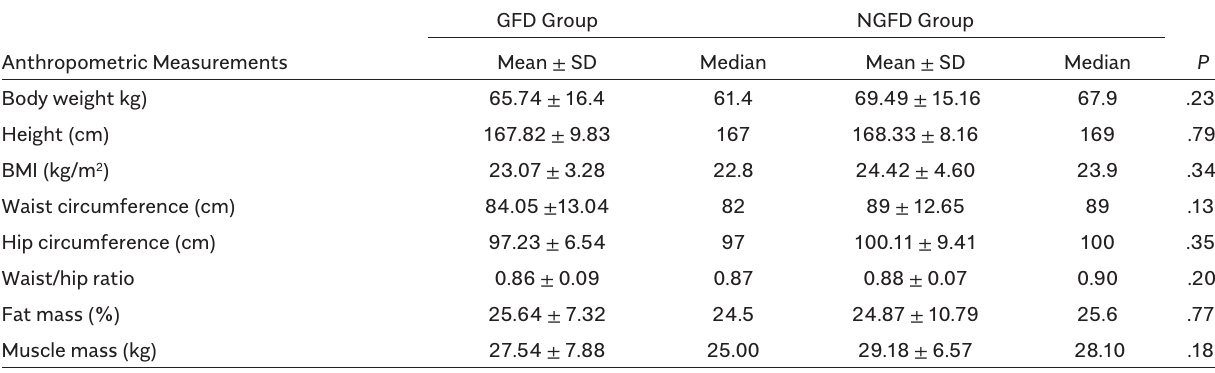
Table 5. Anthropometric Measurements of